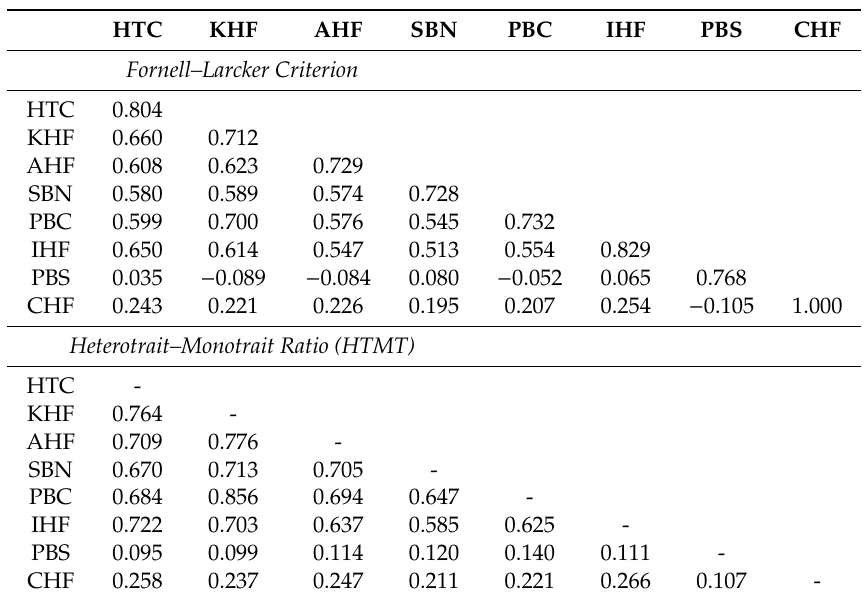
Table 3. Discriminant validity.